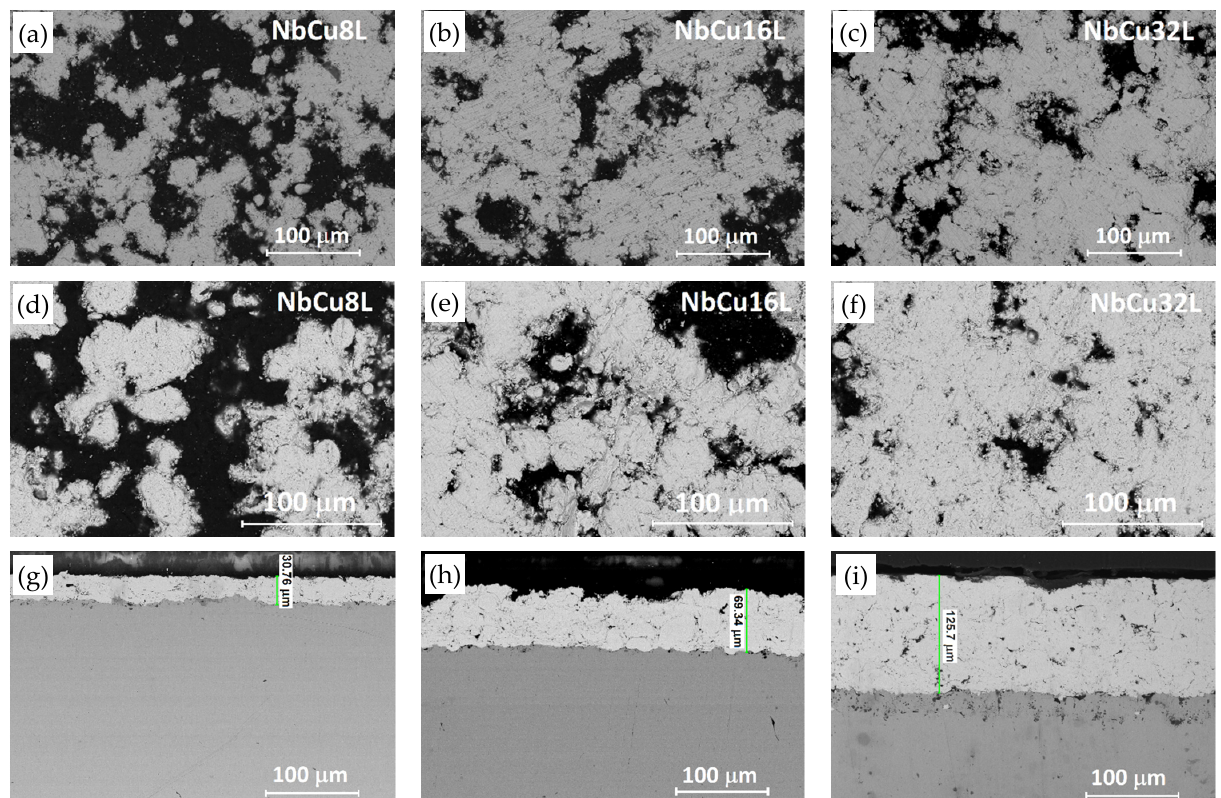
Figure 1. FE-SEM images of Nb coatings on Cu: ( a – c ) surface before corrosion, ( d – f ) surface and ( g – i ) cross-section after corrosion test in 0.05 M H 2 SO 4 + 0.1 ppm F − (pH = 1.4).